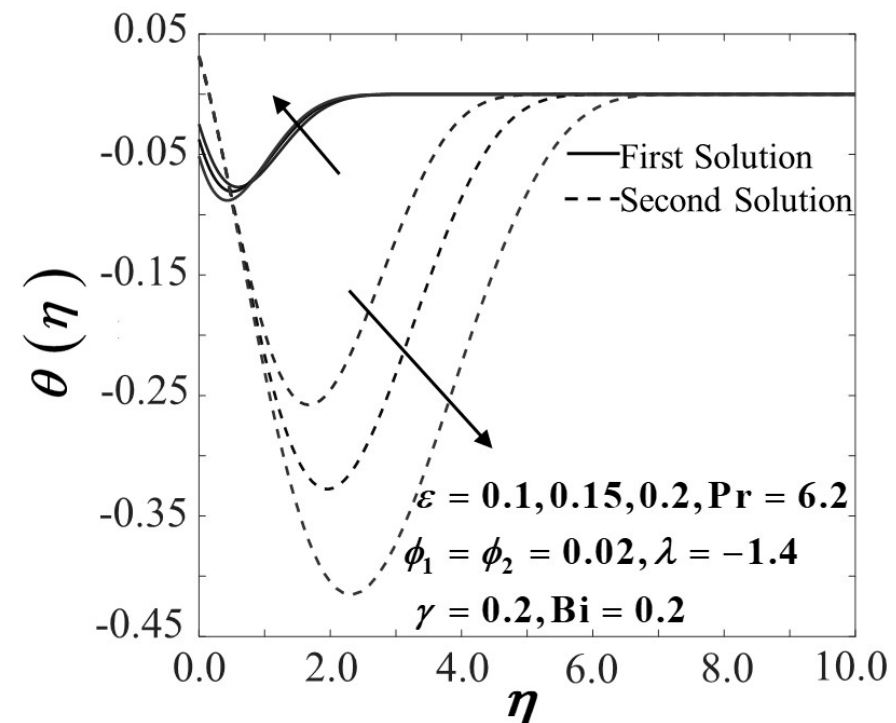
( ) θη with 0.10,0.15,0.20. ε=